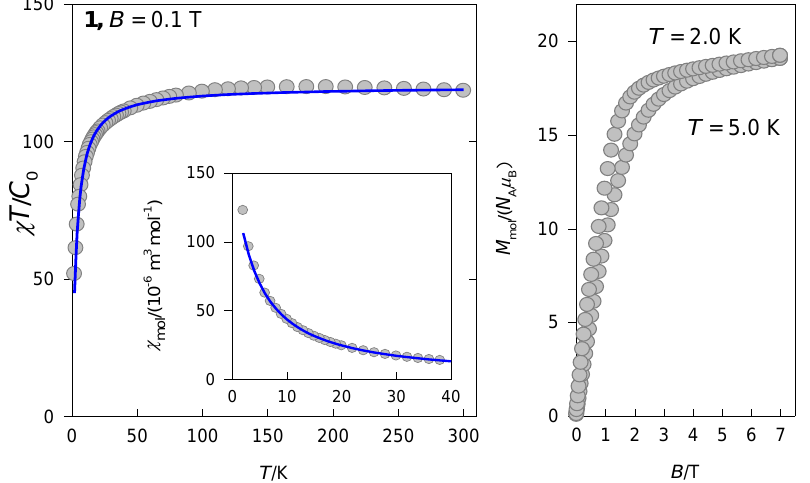
Figure 3. Plot of the χ T vs. T for 1 in an applied magnetic field of B DC = 0.1 T. Solid lines—fitted (see main text). Right — field dependence of the magnetization per formula unit.